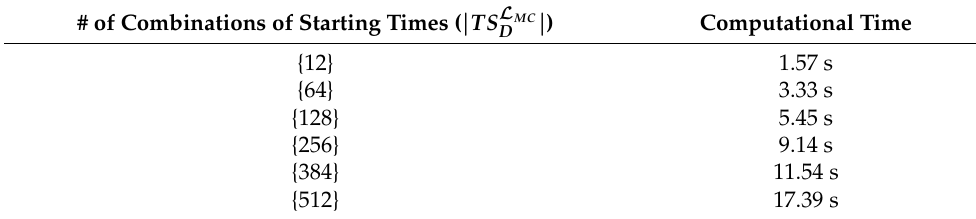
Table 13. Sensitivity of computational times with respect to the number of possible starting time